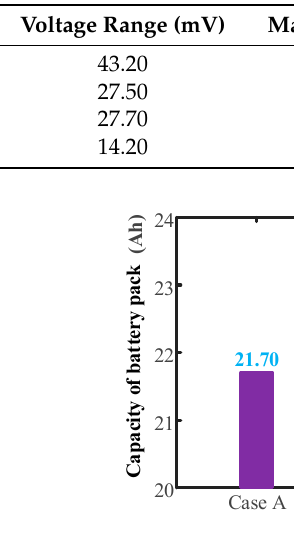
Figure 6. Battery pack capacity after charging.